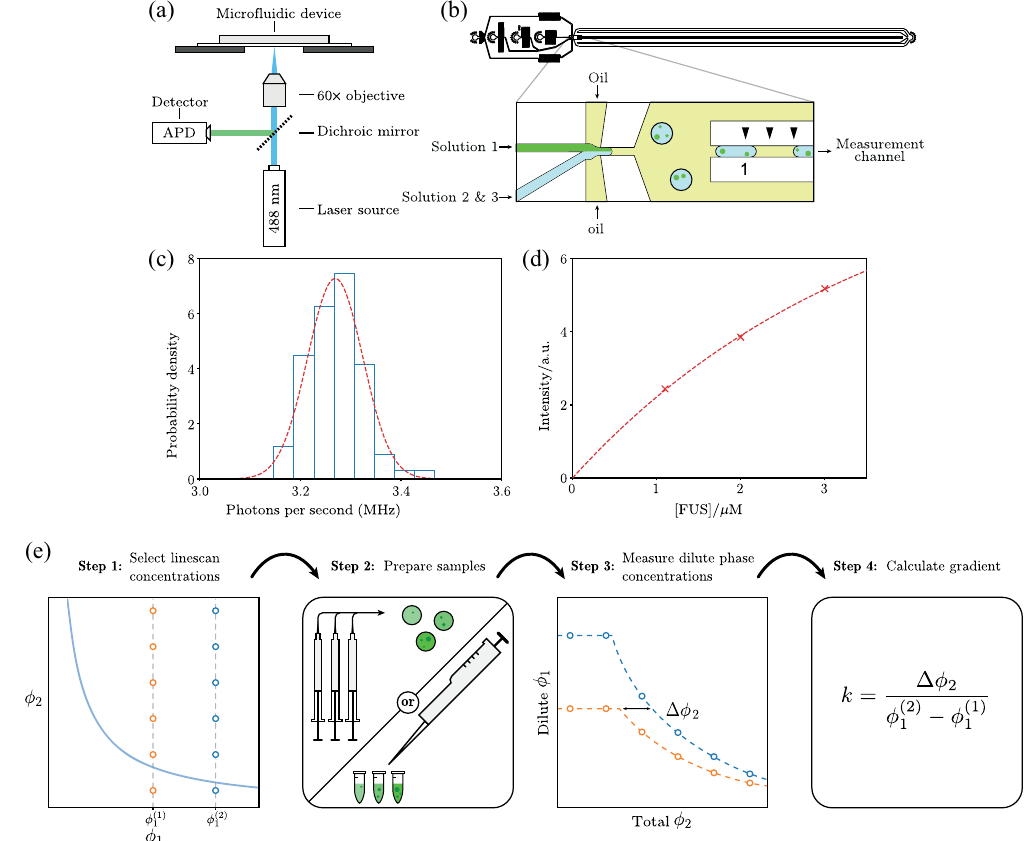
FIG. 5. Experimental overview. (a) Simplified illustration of the home-built confocal measurement setup described in detail elsewhere [47]. (b) Microfluidic device used, with an enlarged view of the droplet-generation section. (c) Histogram of mean baseline signal for individual droplets. The red dashed line is a Gaussian distribution using the mean and standard deviation calculated for the series of droplets. (d) Calibration curve for correlating signal to actual concentration. The data (red crosses) are fit to a quadratic curve (dotted line). (e) Schematic showing the general workflow of the proposed tie-line gradient measurement approach. The exact method used to quantify dilute phase concentrations is not specific to the approach.